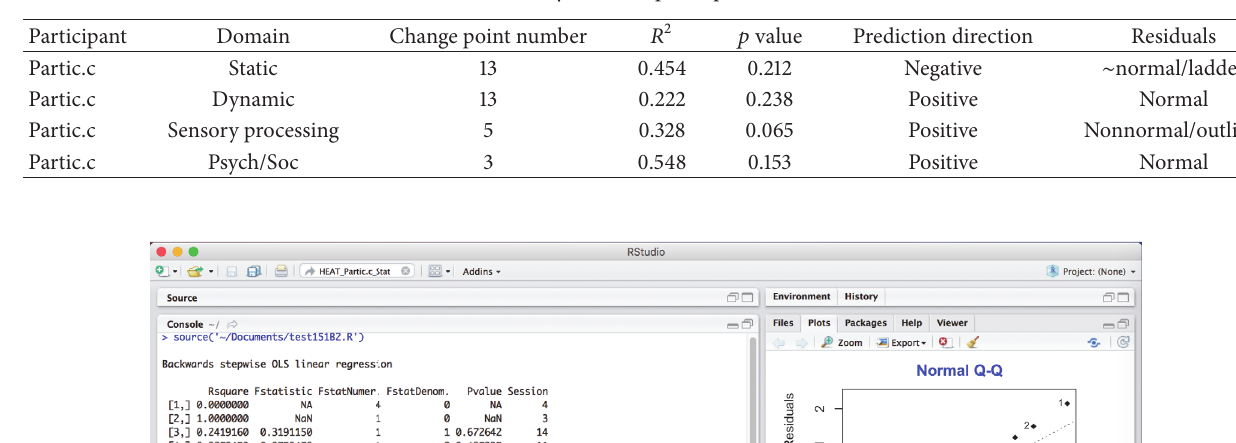
Table 4: SPRE analysis of one participant for each variable.